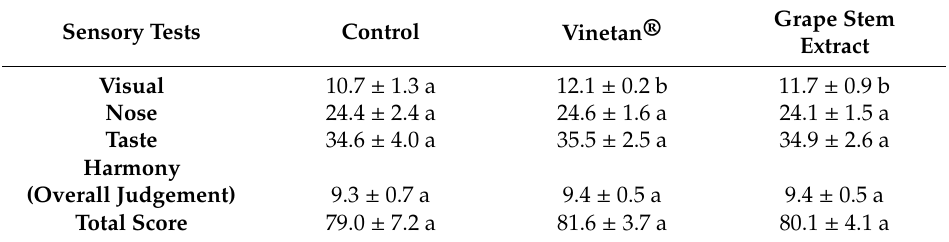
Table 5. Results of the sensory test of wines produced with only SO 2 at usual concentrations (control), or with grape stem or Vinetan ® extracts and reduced doses of SO 2 , before bottling (Mean ± SD, n = 18).